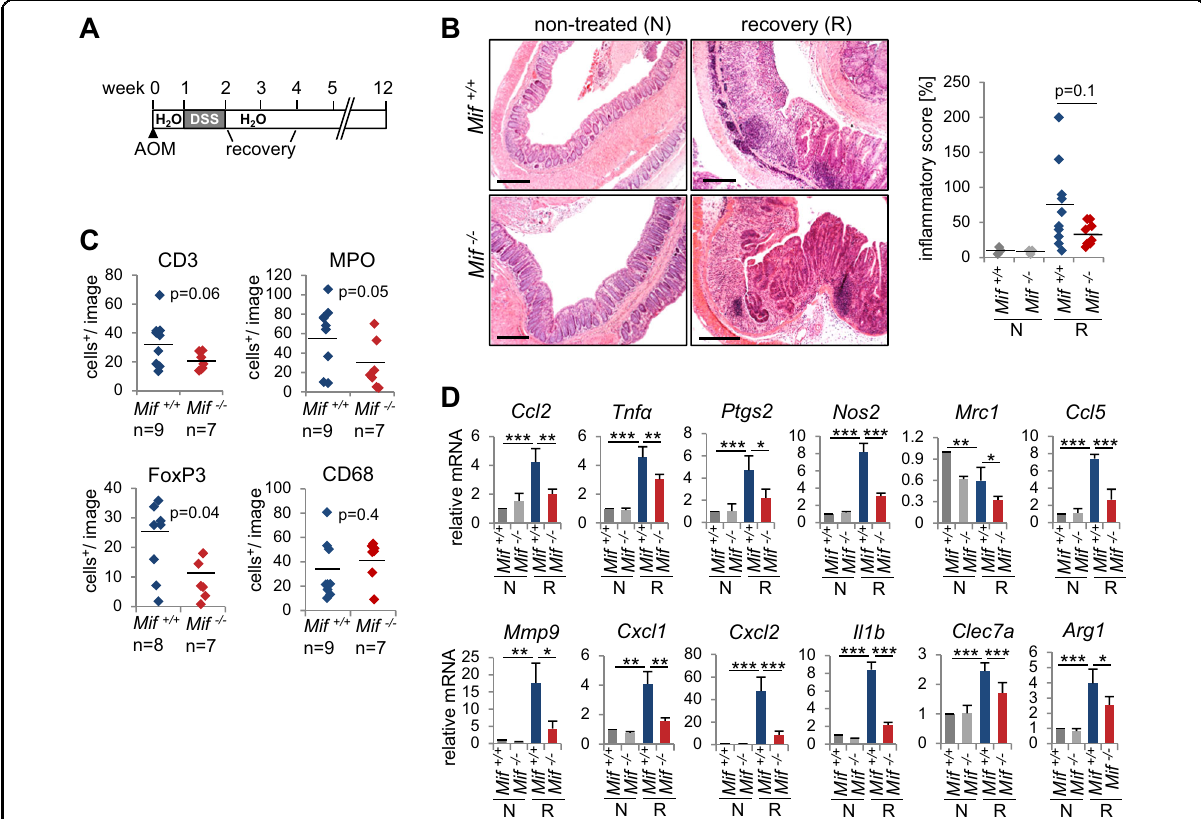
Fig. 3 A Mif deletion protects mice from in fl ammation-associated cancer initiation. A Schematic of the AOM/DSS mouse model. CRC was initiated by a single AOM injection, followed by one cycle of DSS administration. At 8 days of post-DSS treatment, mice were analyzed for recovery. B Representative H&E staining of colonic tissues from the indicated mice 8 days post-DSS (recovery = ‘ R ’ ) or from untreated control mice ( ‘ N ’ ). Scale bars, 300 µm. (Right) The ‘ in fl ammatory score ’ was assessed based on tissue morphology and immune cell in fi ltration. (Left) Nontreated mice, n = 3/ group; recovery Mif + / + mice, n = 10, Mif − / − mice, n = 8. Black lines, mean. p values were calculated with ANOVA Bonferroni ’ s multiple comparison test; p = 0.0455. Indicated groups, calculated with Student ’ s t test. C Quanti fi cation of the indicated histological staining of colonic tissues 8 days post-DSS ( ‘ recovery ’ ) in Mif + / + and Mif − / − mice. n , mouse numbers. Five to seven images (area = ×40 magni fi cation) per mouse were analyzed for positively stained stromal cells. Black lines, mean. D mRNA levels of in fl ammatory genes in recovering ( ‘ R ’ ) and nontreated ( ‘ N ’ ) colonic tissues. Single samples from the indicated genotypes/groups were pooled (nontreated, n ≥ 3; recovering tissue, n ≥ 4). qRT-PCR was performed, and the expression levels were normalized to those of Rplp0 mRNA. Means ± SD of ≥ 3 technical replicates/pools, each pipetted. C , D p values were calculated with Student ’ s t test comparing the indicated groups. * p ≤ 0.05, ** p ≤ 0.01, *** p ≤